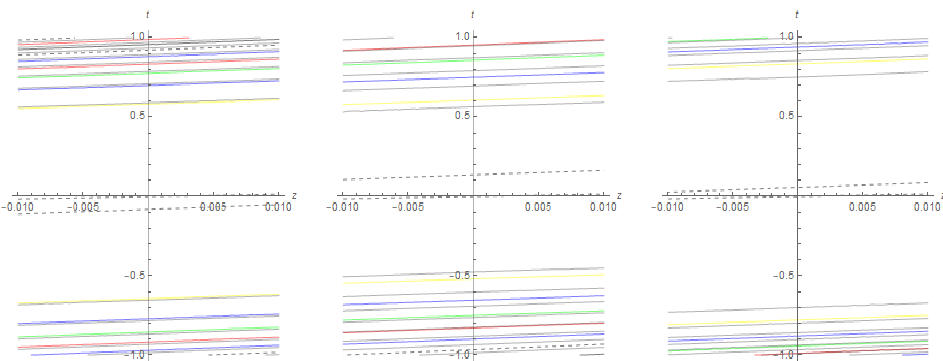
Figure 18. Contour slots for Figure 17.